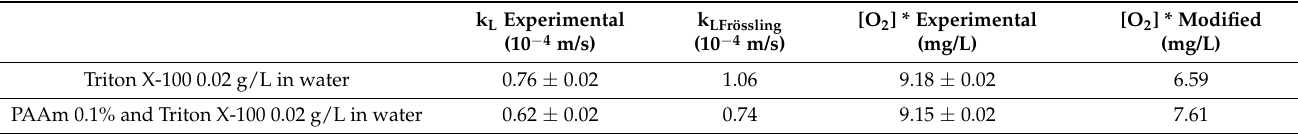
Table 5. Modification of the value of oxygen